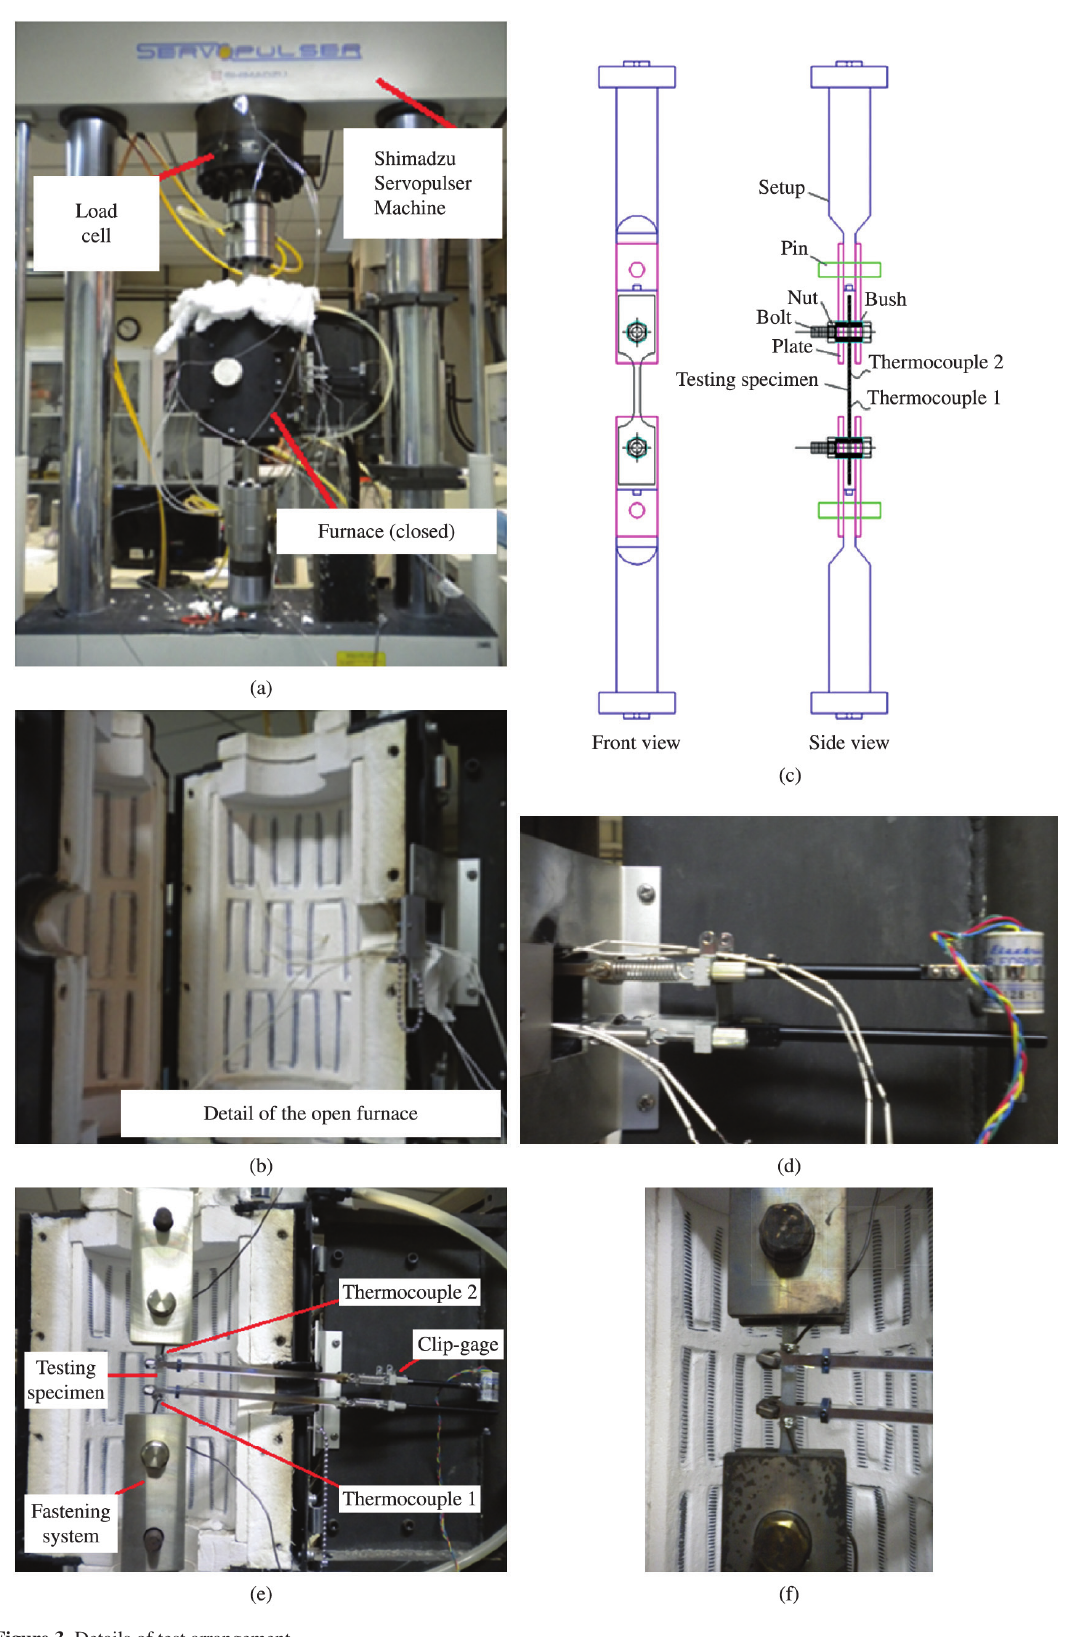
Figure 3. Details of test